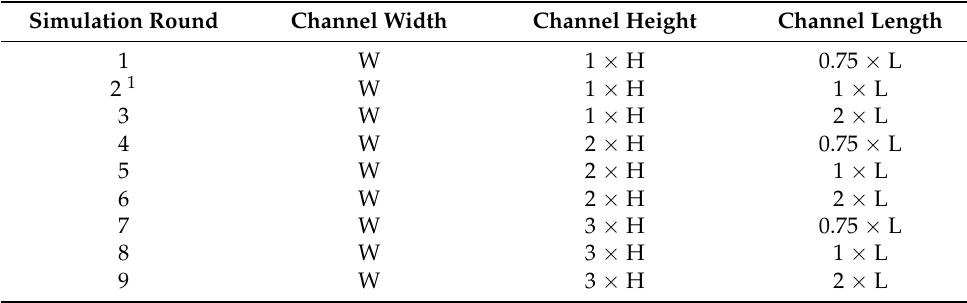
Table 1. Different dimensions of microchannel geometry for simulation. Simulation Round Channel Width Channel Height Channel